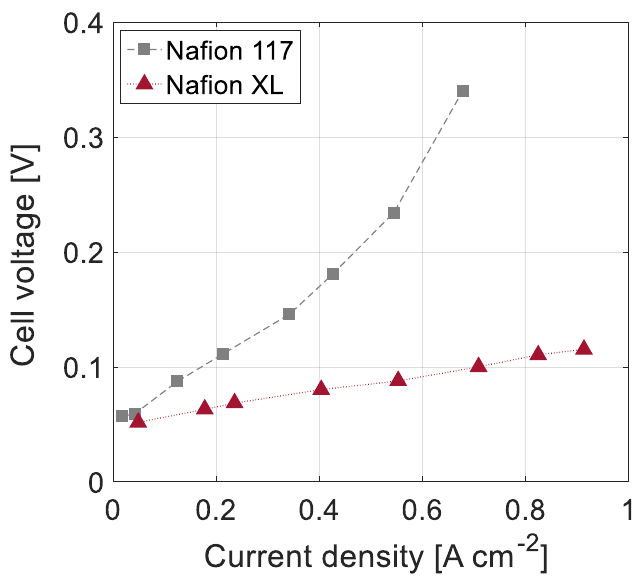
Figure 9. Polarization curves for different membranes (T = 333 K, stoichiometry 1.2, relative humidity of inlet hydrogen = 90%, discharge pressure = 4 MPa).